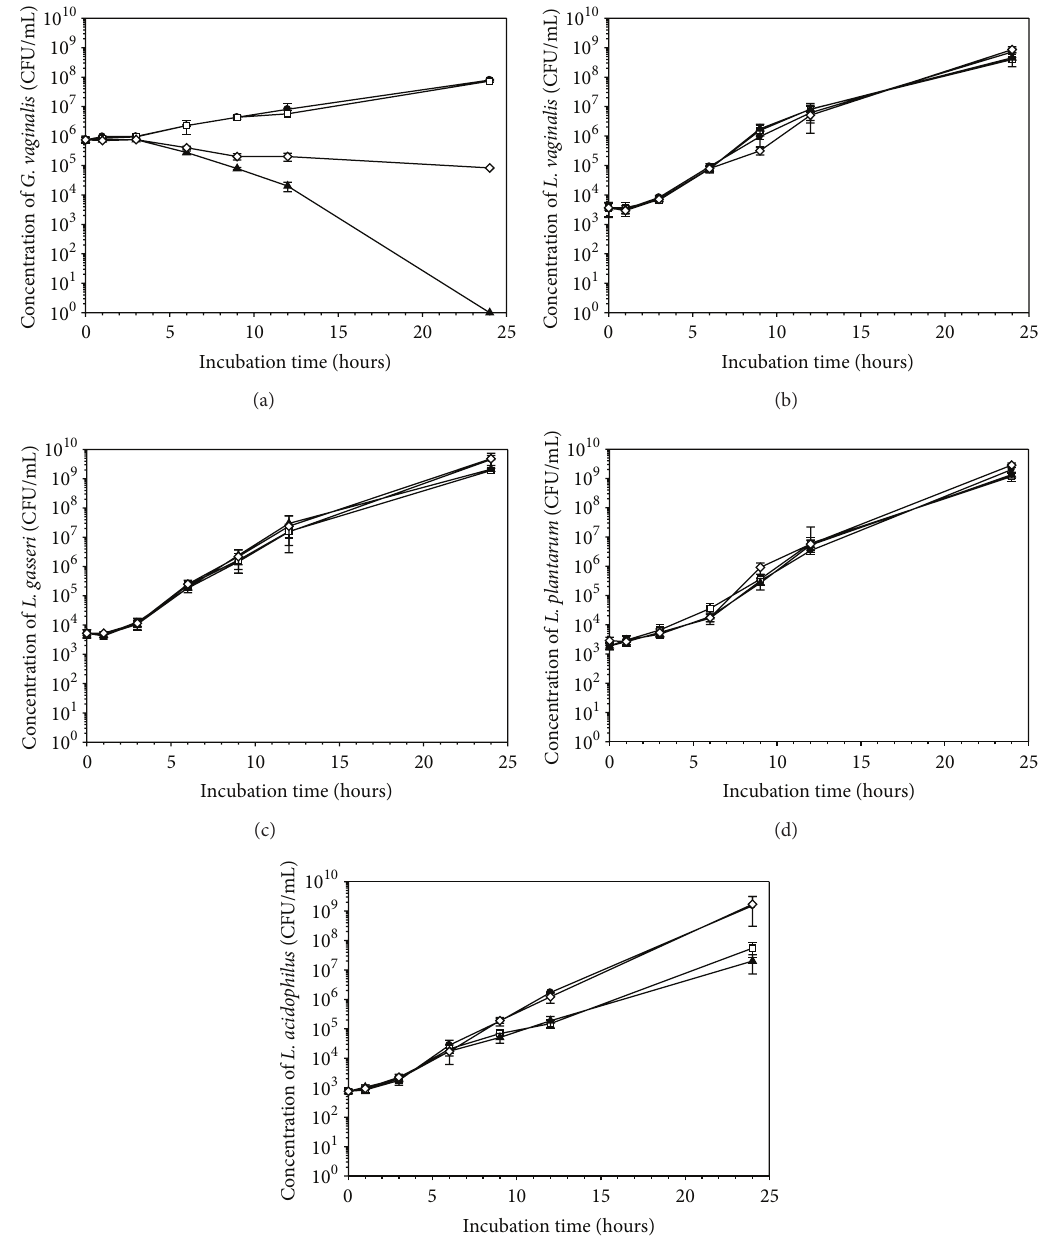
Figure 2: BPO inhibits G. vaginalis (a) but not healthy vaginal lactobacilli L. vaginalis (b), L. gasseri (c), L. plantarum (d), and L. acidophilus (e) in direct exposure experiments. ( ∙ ) represents the negative control, ( ◻ ) represents the base gel, ( 󳵳 ) represents 1% BPO hydrogel, and ( ◊ ) represents BPO particles. Experiments were conducted at least twice in duplicate. Mean values and standard deviations are